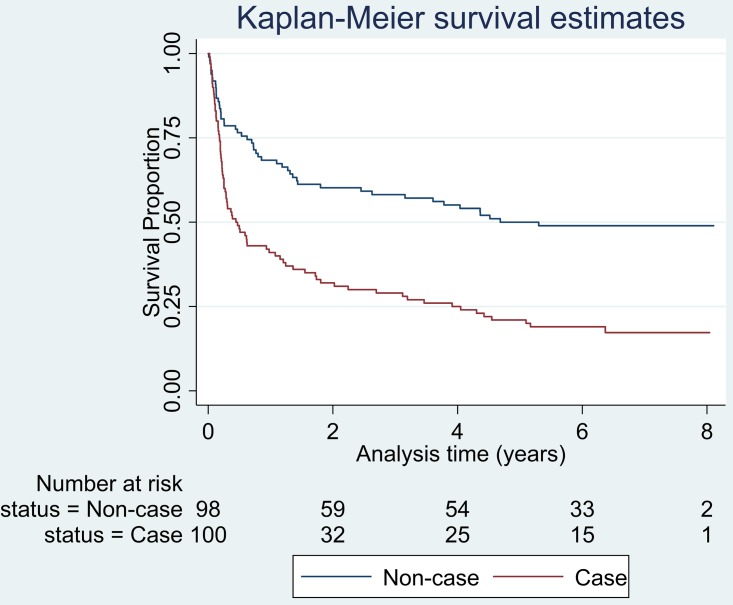
Kaplan-Meier survival estimates of non-cases and Clostridium difficile cases.